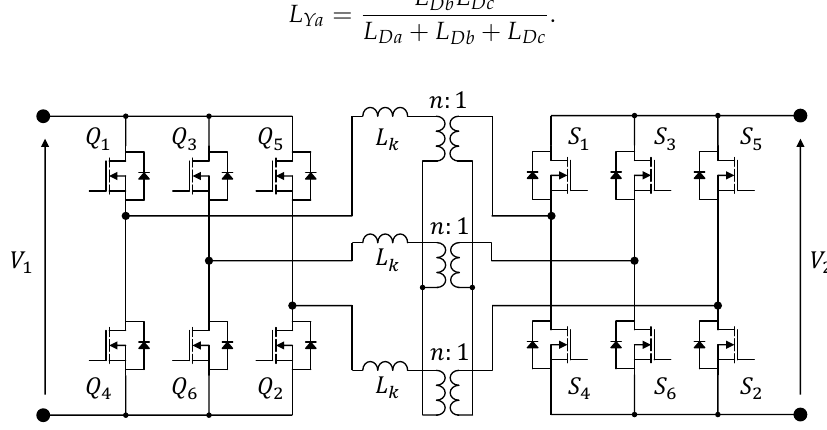
Figure 2. Three-phase dual active bridge converter